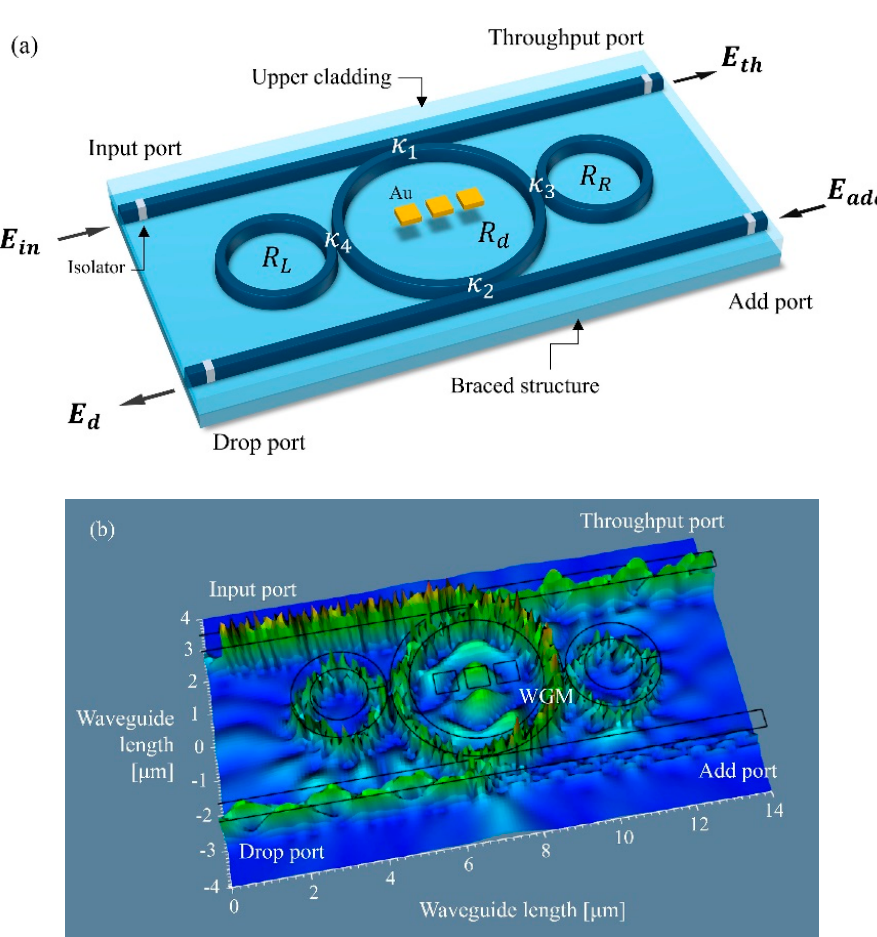
Figure 1. The schematic of a successive filtering circuit applied for the mindfulness model and simulation, which is a plasmonic circuit, where ( a ) is the schematic circuit, and ( b ) the trapped electron distribution in the circuit. The gold gratings are embedded within the centering to form the electron cloud distribution in the silicon circuit. The input, throughput, add port, and drop ports are Ein, Eth, Eadd, and Ed, respectively. Rd: central ring radius, RR and RL: side ring radii, and K1–K4: coupling constants. The isolator is applied to protect the feedback against the input